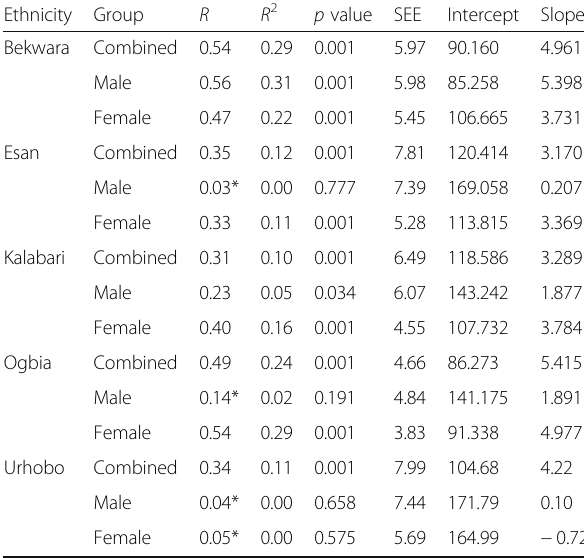
Table 6 Result of simple regression analysis between